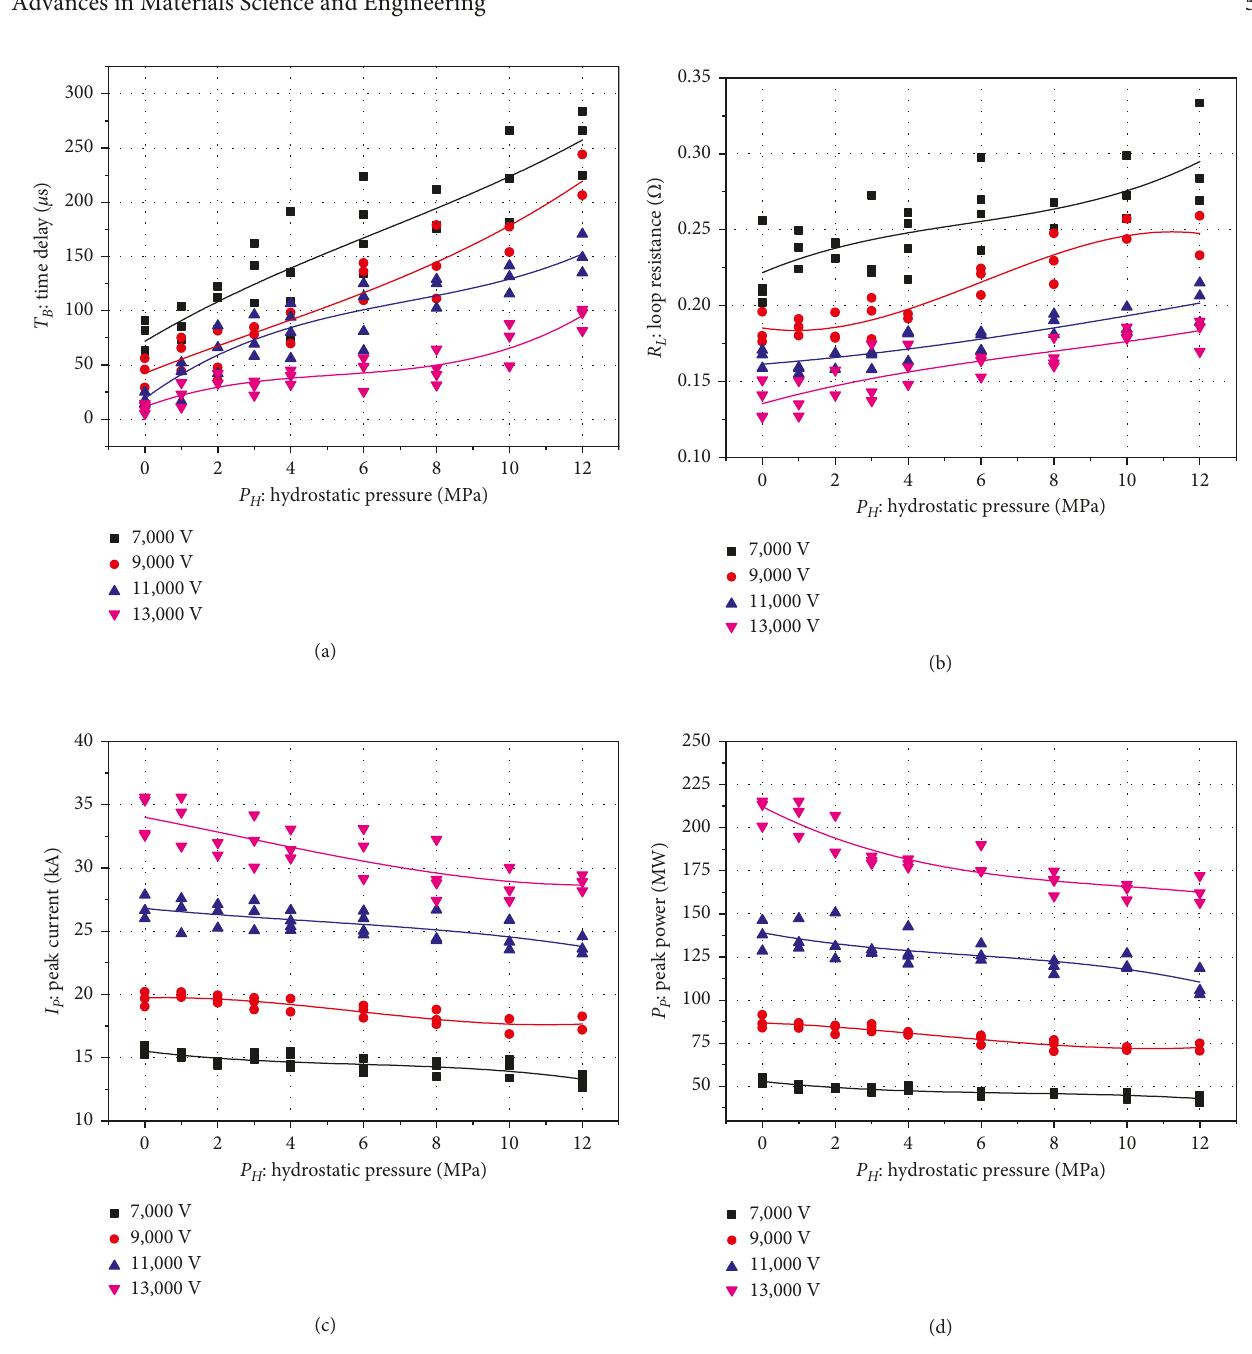
Figure 6: Variation diagram of (a) T B , (b) R L , (c) I P , and (d) P P versus P H for a range of U D and P H